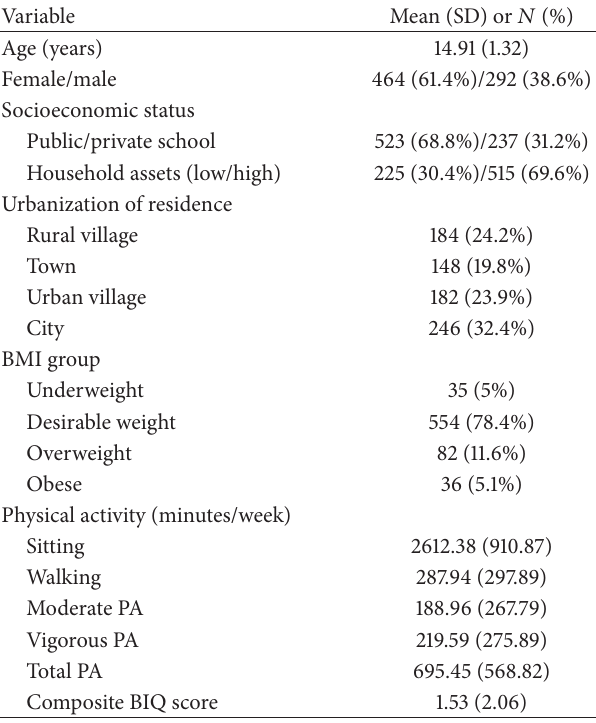
Table 1: Demographic